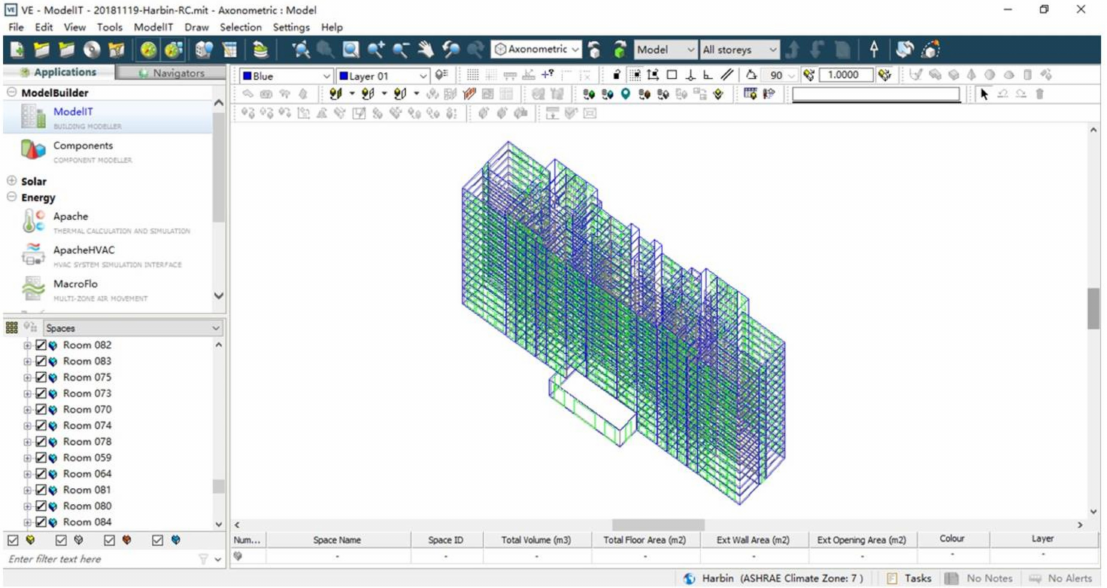
Figure 7. Established model in integrated environmental solution (IES) software platform.